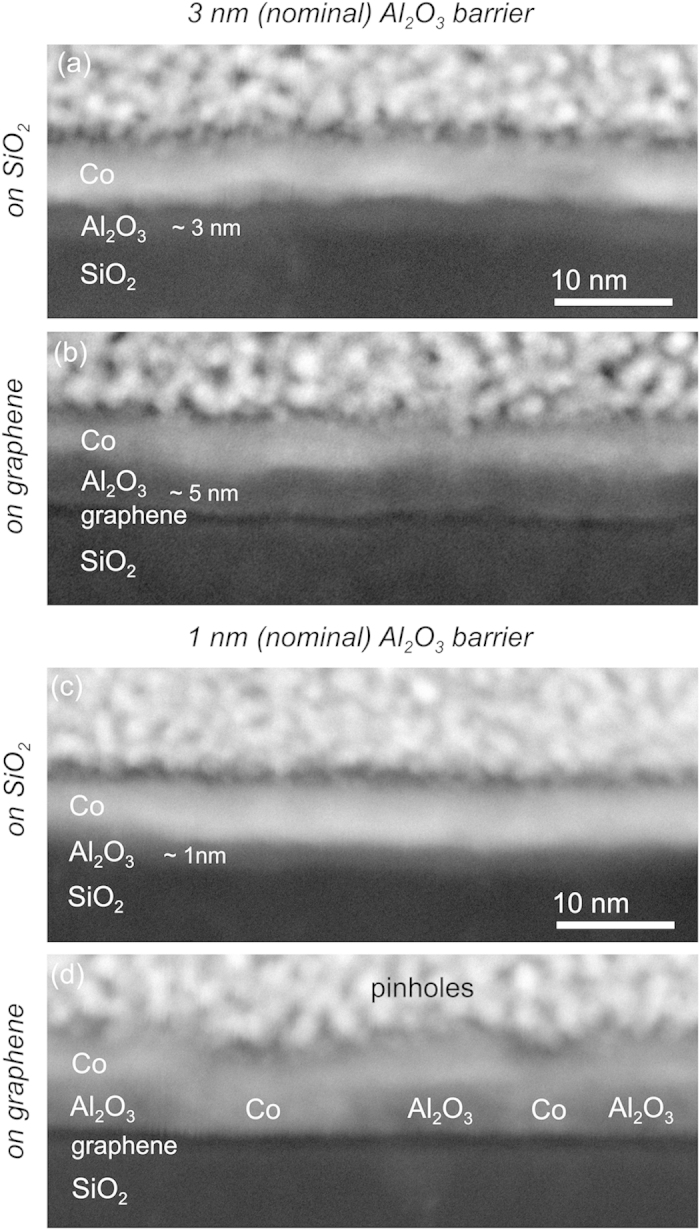
HAADF-STEM cross-sectional images of samples with different Al2O3 barrier thicknesses, 3-nm-thick (nominal) barrier on (a) SiO2 and (b) graphene, 1-nm-thick (nominal) barrier on (c) SiO2 and (d) graphene.